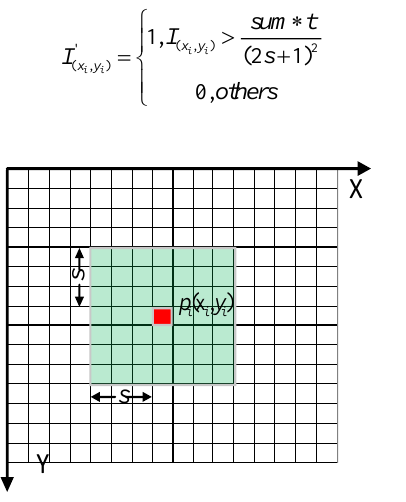
Figure 3. Adaptive threshold